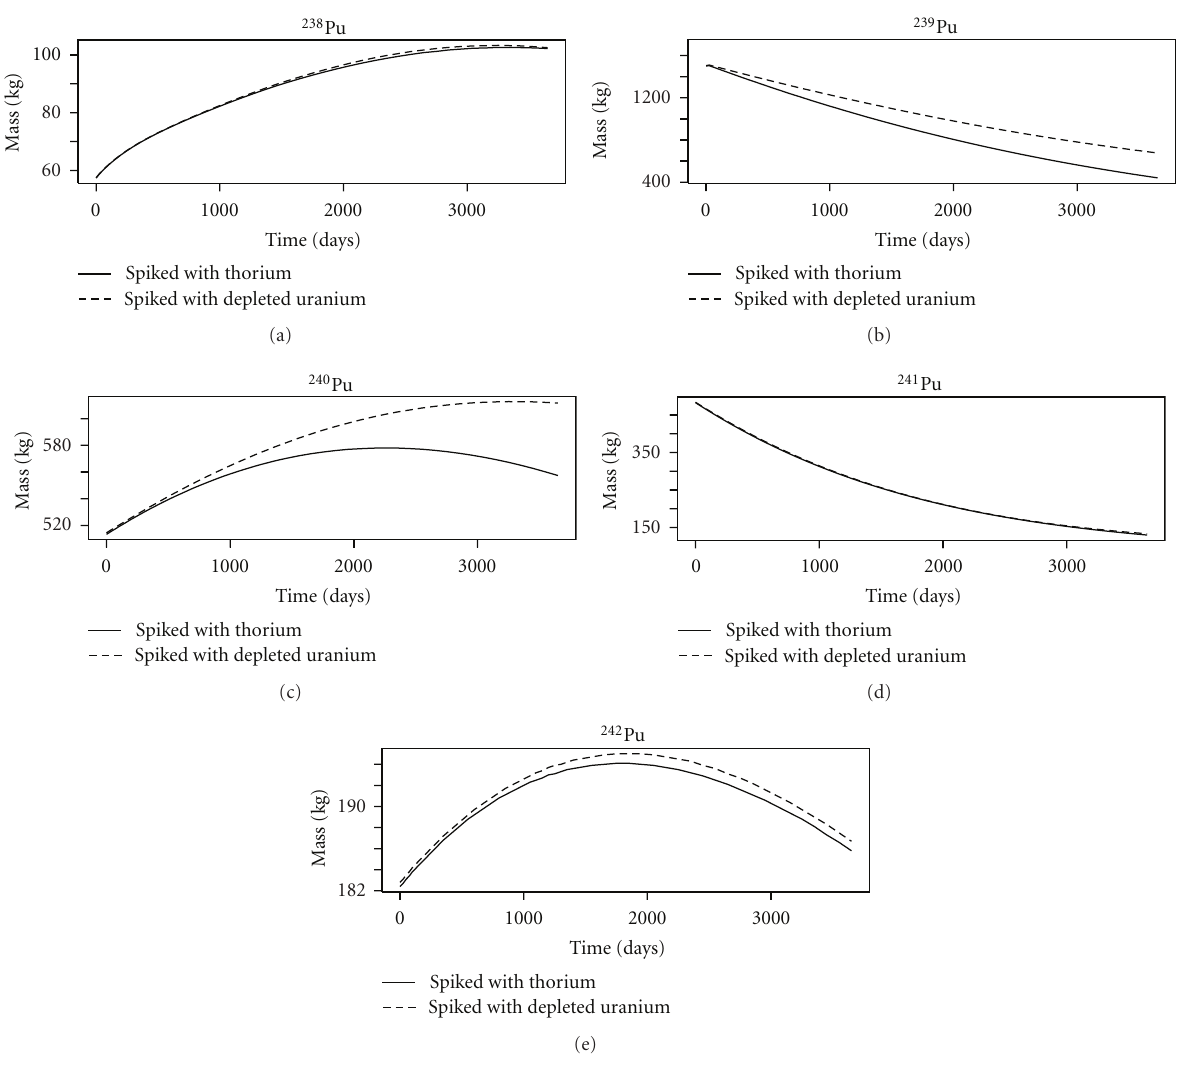
Figure 6: Plutonium mass